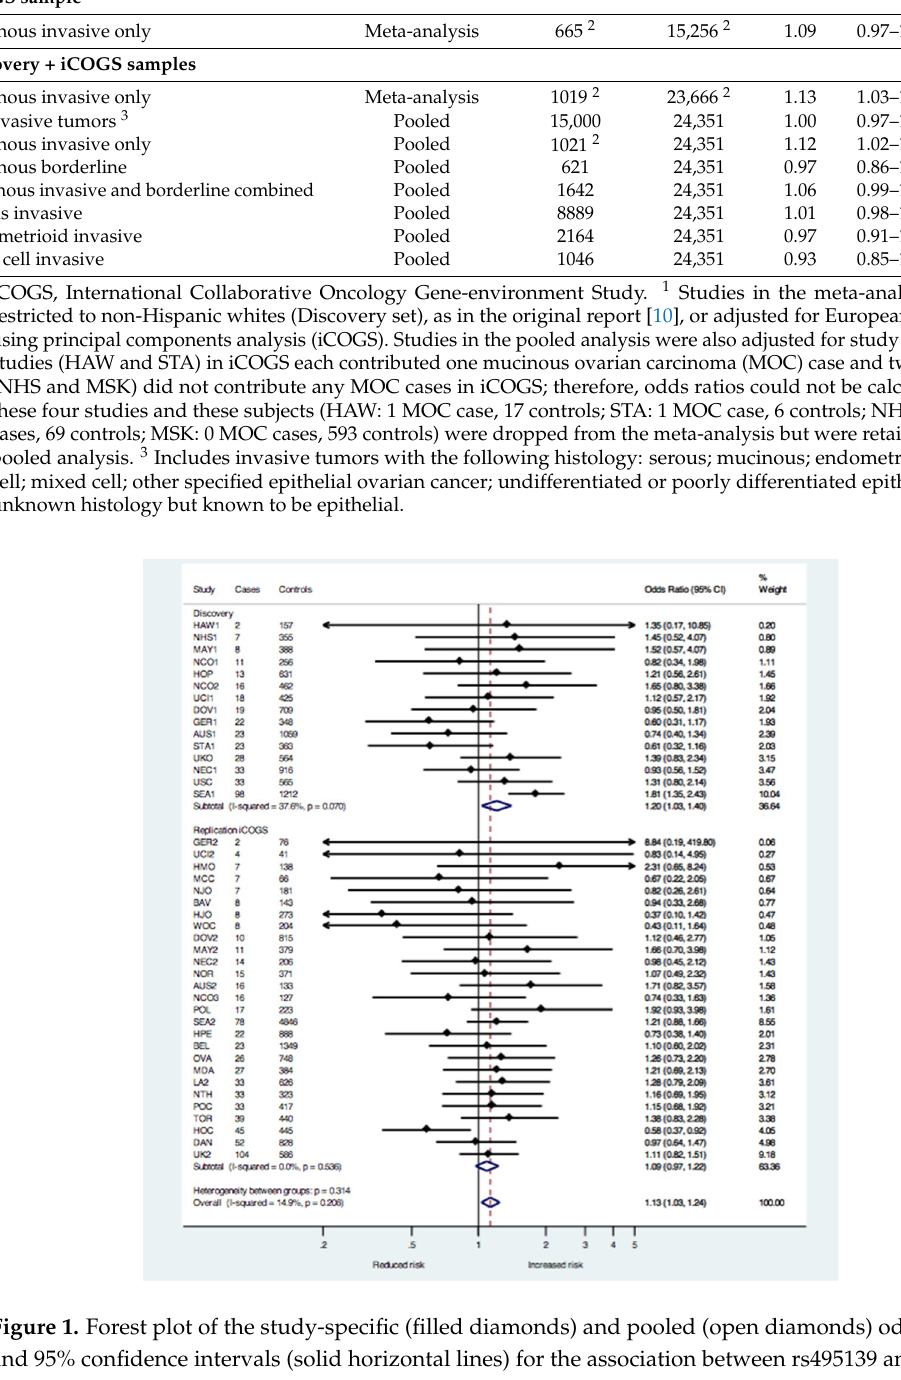
Table 1. Associations 1 between rs495139 and ovarian carcinoma among European subjects.